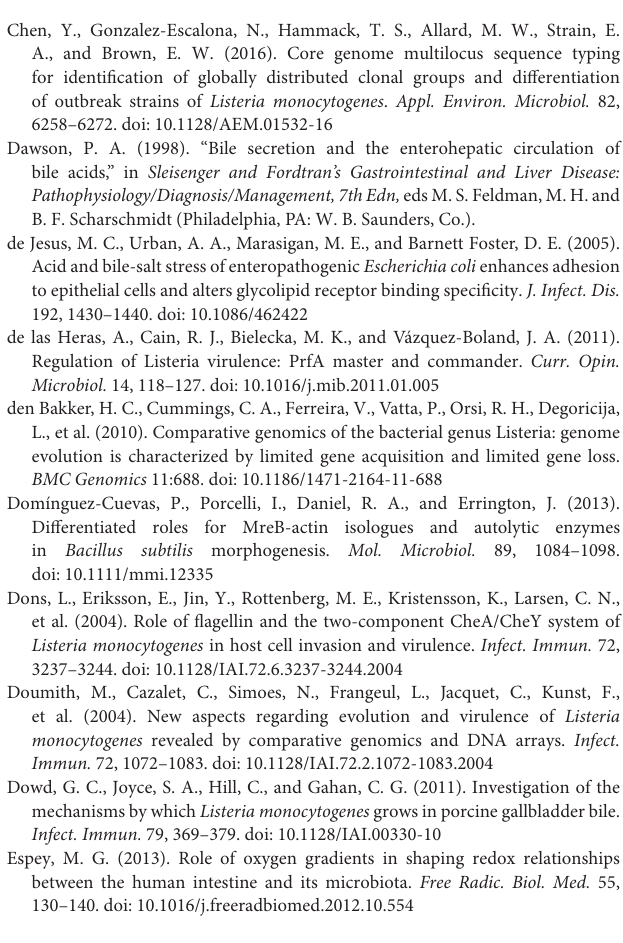
Supplementary Table 3 | Examples of functionally interesting genes upregulated by